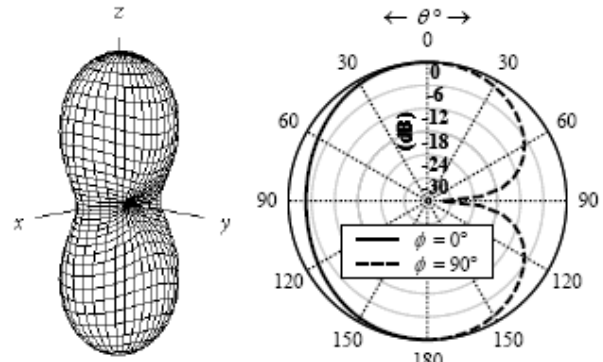
Figure 10: Radiation patterns of the 3-elements CCLA at 900 MHz.